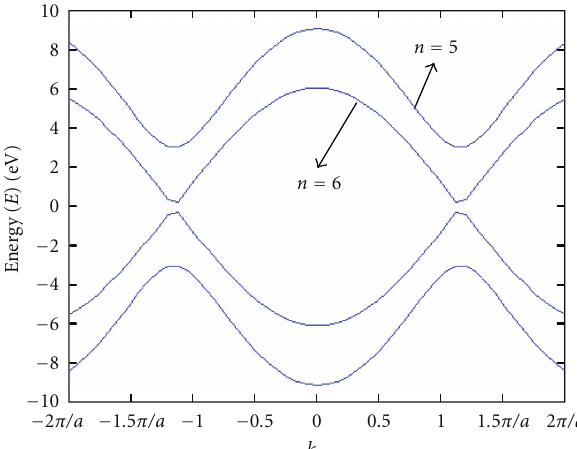
Figure 7: The energy dispersion variations of zigzag carbon nanotubes. One nanotube is metallic with n = 0 and m = 6, and the other is semiconductive with n = 0 and m =